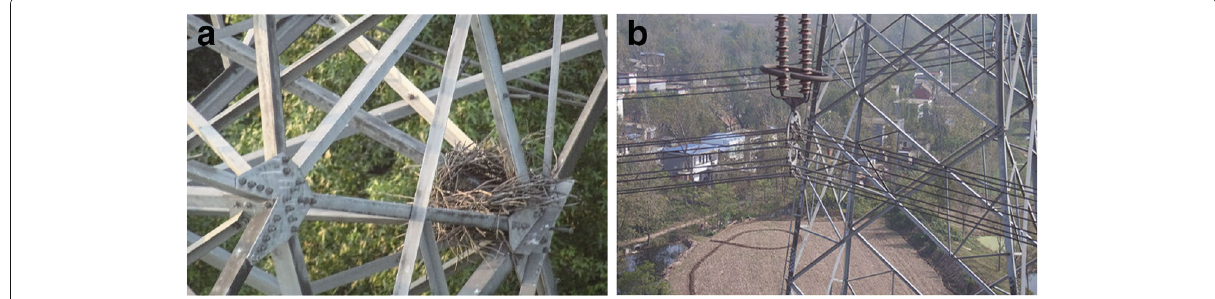
Fig. 4 Two original images for feature test